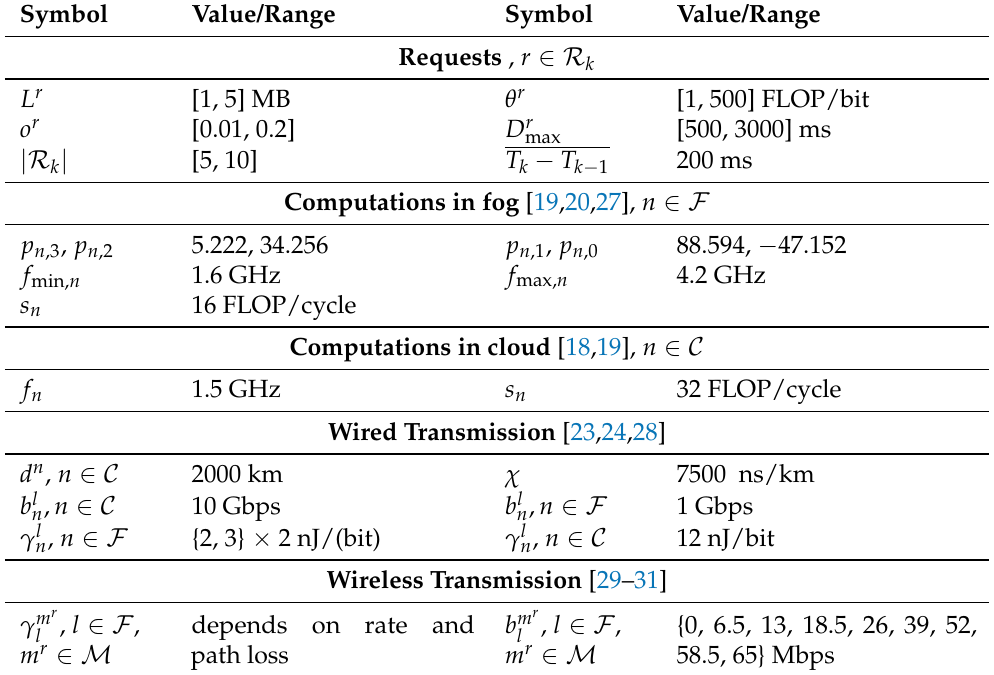
Table 4. Simulation